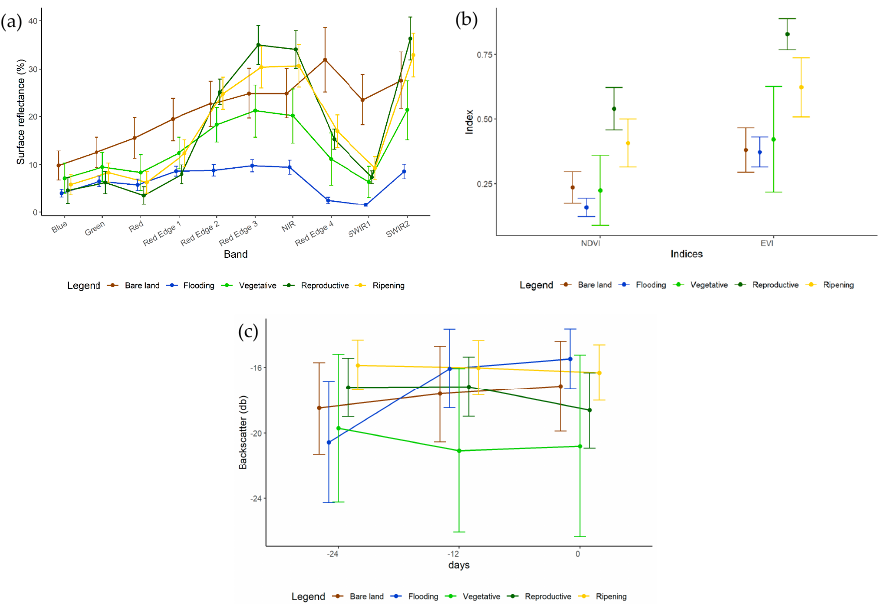
Figure 6. ( a ) The means of spectral bands from Sentinel-2 values, ( b ) the means of NDVI and EVI values from MOD13Q1, and ( c ) the means of Sentinel-1 VH values regarding bare land, flooding, and rice growth stages. The bands are o ff set for visualization and error bars represent standard